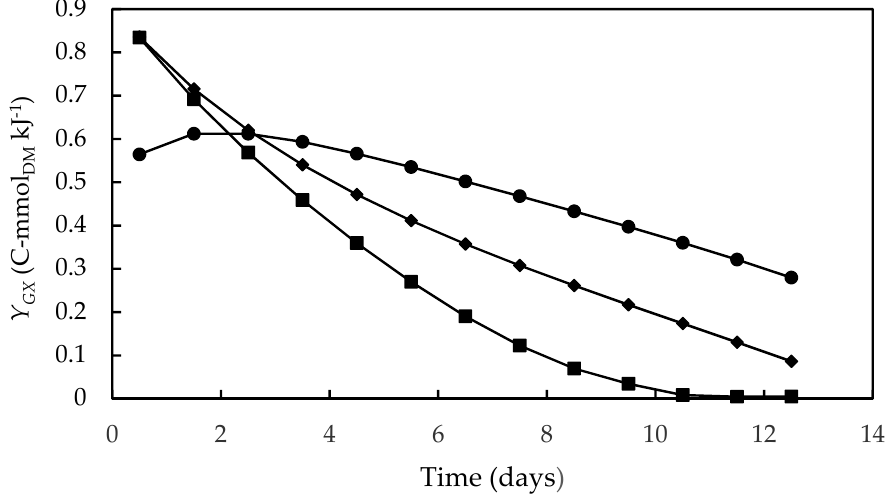
Figure 3. Biomass yield on Gibbs energy dissipation during cultivations of D. tertiolecta carried out in di ff erent culture media. F / 2 medium ( (cid:4) ), Bold’s Basal medium ( • ), Alternative medium ( (cid:117) ).